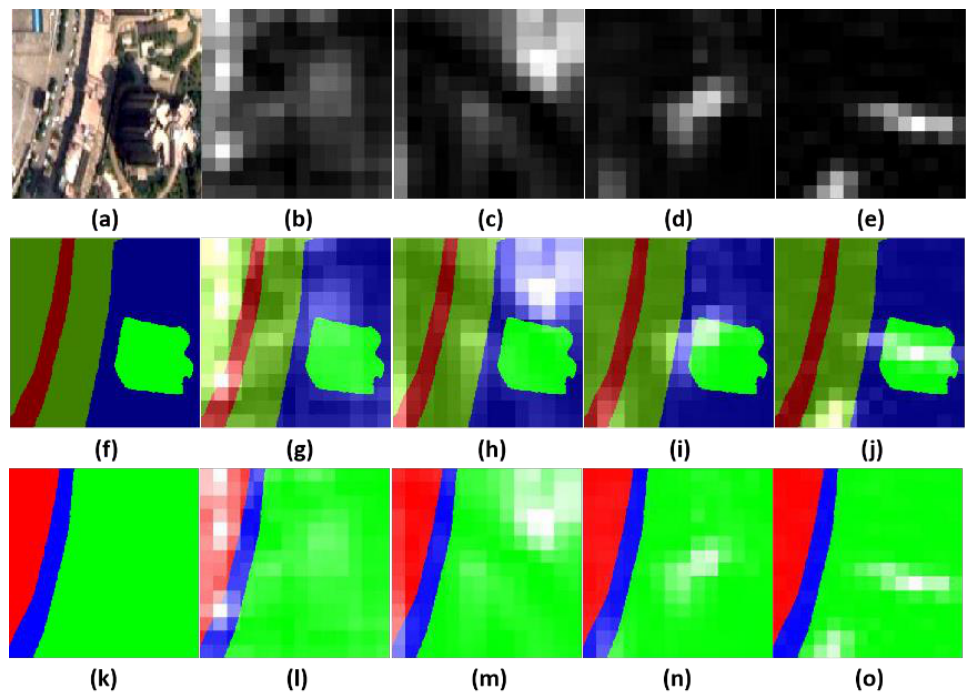
Figure 6. Remote sensing object recognition and correction. It shows the process of multi-scale remote sensing object recognition. ( a ) is the input image; ( b – e ) are the attention maps for generating “service,” “green_space,” “service,” and “residence,” respectively; ( f ) is a small-scale segmentation map of ( a ); ( g – j ) are overlaid maps of ( b – e ), respectively, with ( f ); ( k ) is a large-scale segmentation map of ( a ); ( l – o ) are overlaid maps of ( b – e ), respectively, with ( k ). As shown in ( I,n ), when generating the second “service,” the spatial location of attention weights is incorrect at the small scale, but it is correct at the large scale.